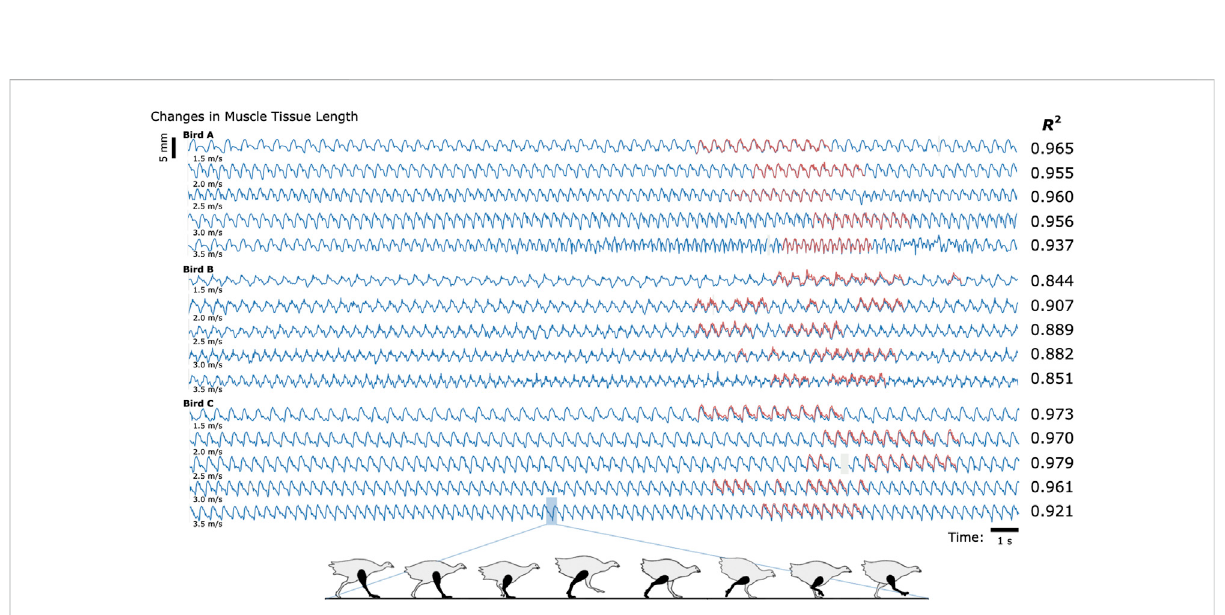
FIGURE 2 Untethered Muscle Tracking During Treadmill Running: Magnetomicrometry Versus Fluoromicrometry. Changes in muscle tissue length measured by MM (blue) and FM (red) for three turkeys at fi ve speeds (30 s shown for each speed). The column to the right of the plots gives the coef fi cients of determination ( R 2 ) between magnetomicrometry and fl uoromicrometry corresponding to each turkey and speed. Gaps in the fl uoromicrometry data are due to researcher selection of full gait cycles during which both magnetic beads were visible in both x-ray images. Gaps in the magnetomicrometry data (gray) are due to packet drops during wireless transmission of the magnetic fi eld signals to the tracking computer (gaps below 50 ms interpolated in gray, gaps above 50 ms highlighted in gray). The turkey gait diagram below the plots shows the corresponding gait phases over one gait